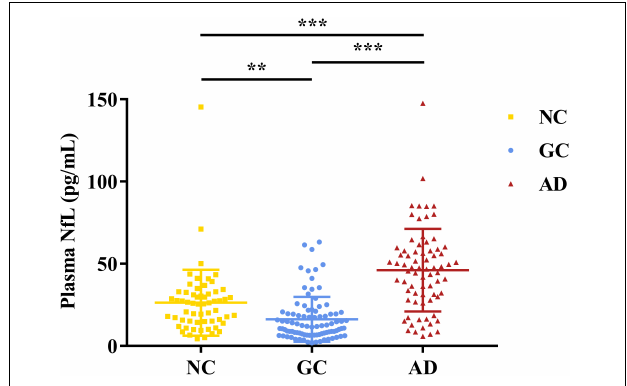
FIGURE 1 | Plasma NfL levels in NCs, GC subjects and AD subjects.The y-axis showsplasma NfL levels in the different groups. Error bars indicate